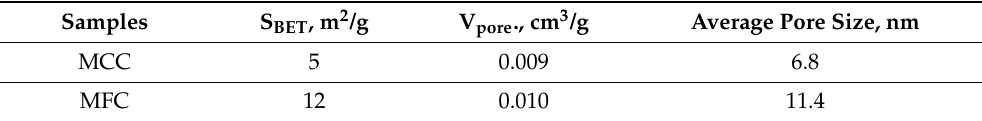
Table 2. Textural characteristics of the MCC and